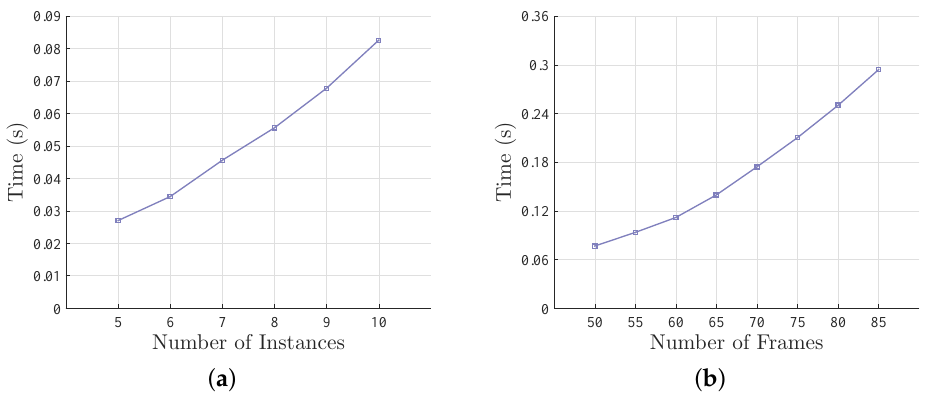
Figure 9. The running times according to ( a ) the number of object instances and ( b ) the number of frames.